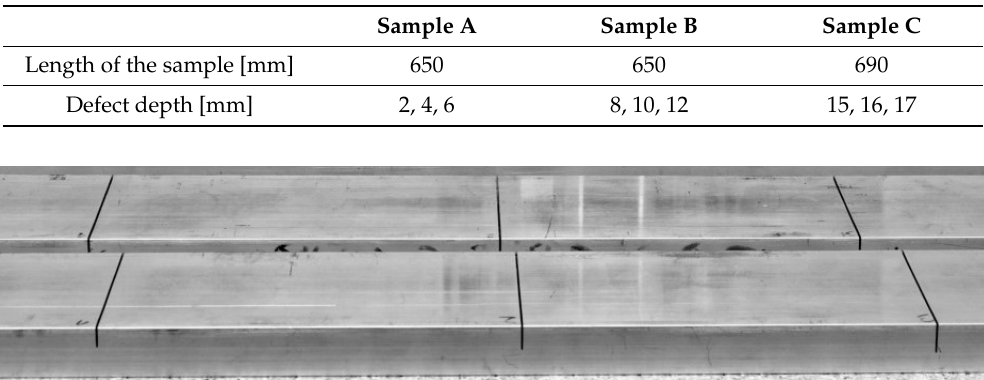
Figure 5. Photo of the aluminum samples with manufactured notches.